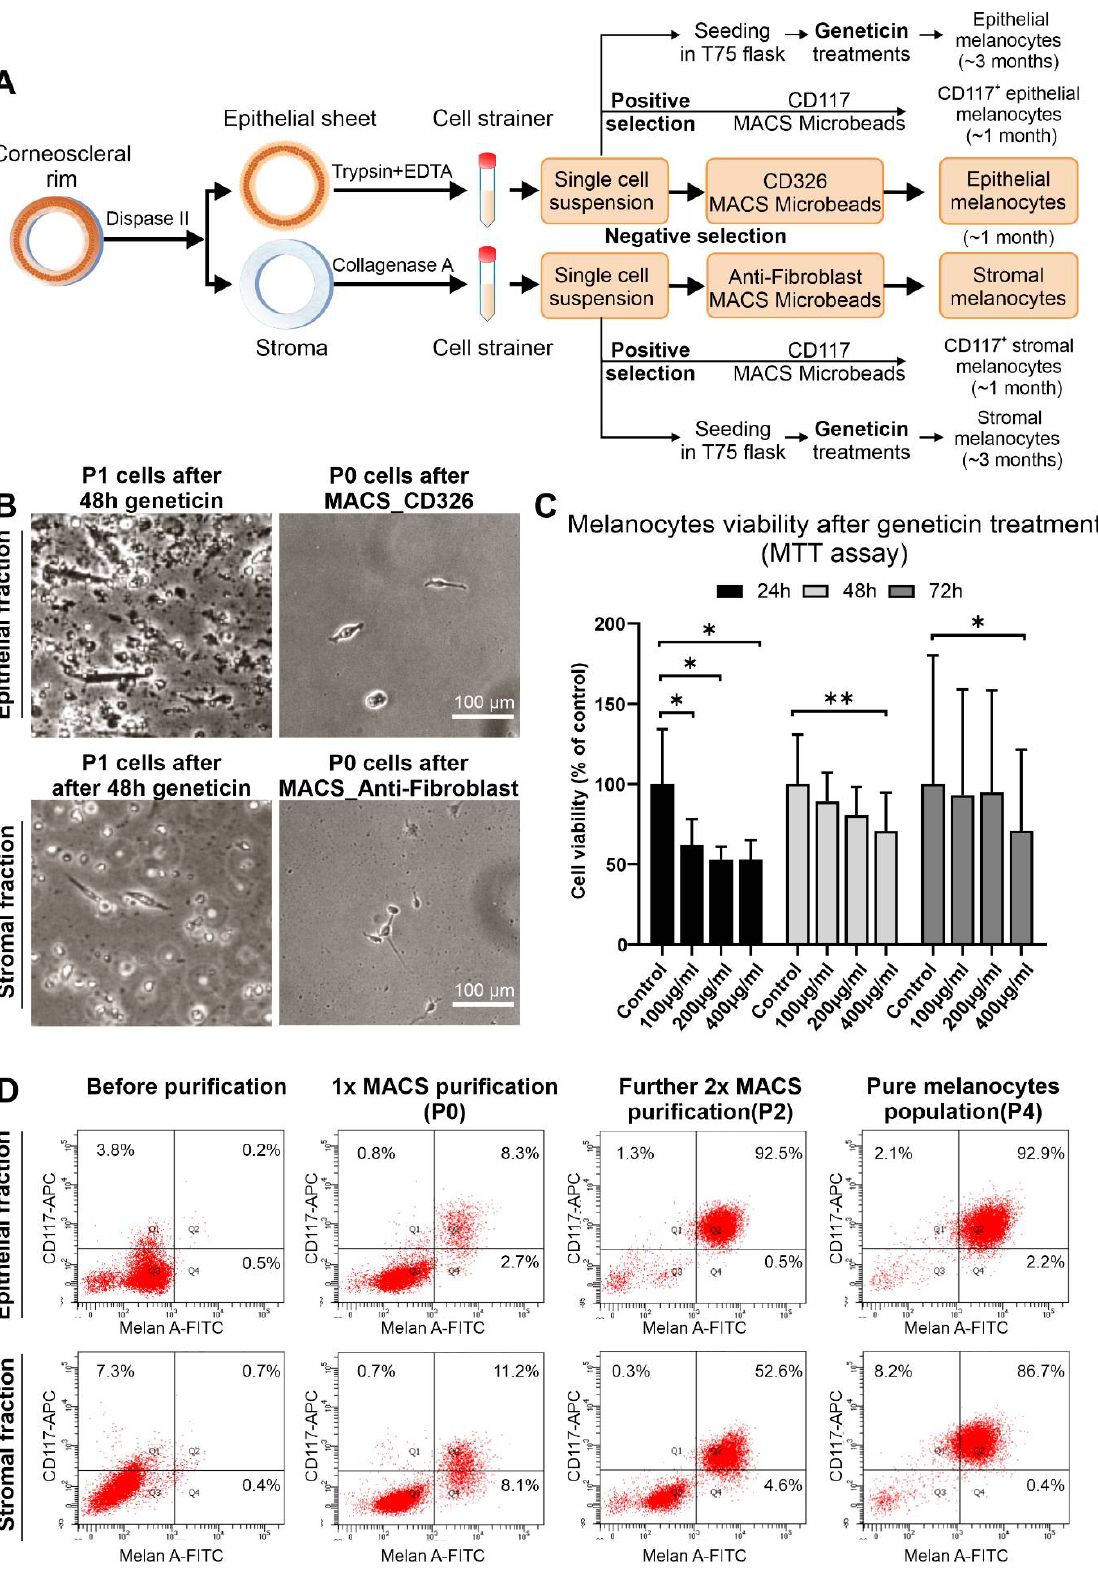
Figure 2. Isolation of limbal epithelial and stromal melanocyte populations using conventional geneticin treatment and magnetic-activated cell sorting. ( A ). Graphical representation of limbal melanocyte isolation: Differential enzymatic digestion of limbal tissue generated single-cell suspensions of epithelial and stromal cells; melanocytes were enriched from both suspensions either by conventional geneticin treatments or by magnetic-activated cell sorting (MACS) technology using either a positive selection approach with CD117 (c-Kit) Microbeads or a negative selection